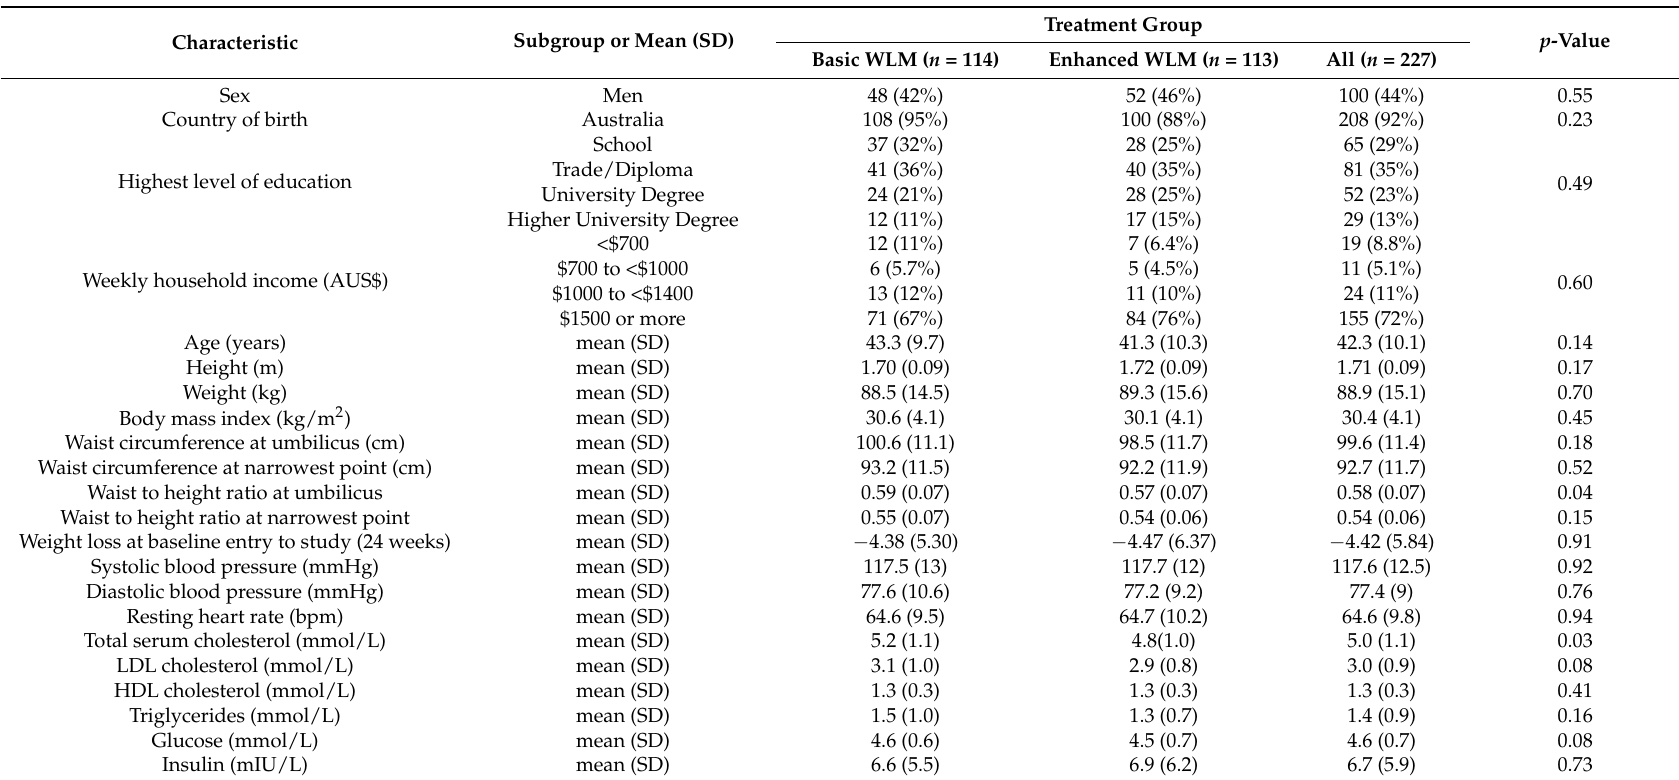
Table 1. Demographic and other baseline characteristics of those randomized to 12 months of either a basic or enhanced features weight loss maintenance (WLM) web-based